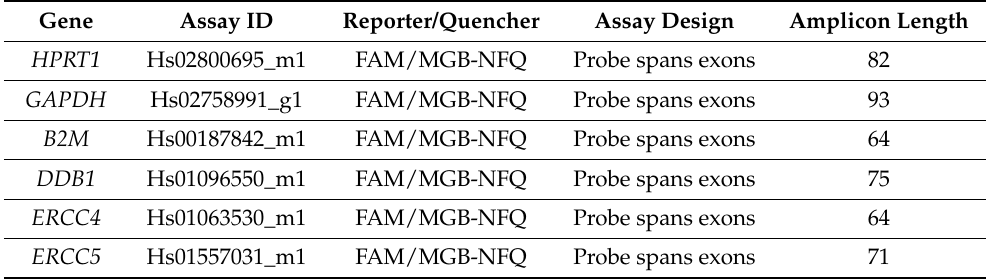
Table 2. Characteristic of TaqMan TM Gene Expression Assays (Applied Biosystems, USA).